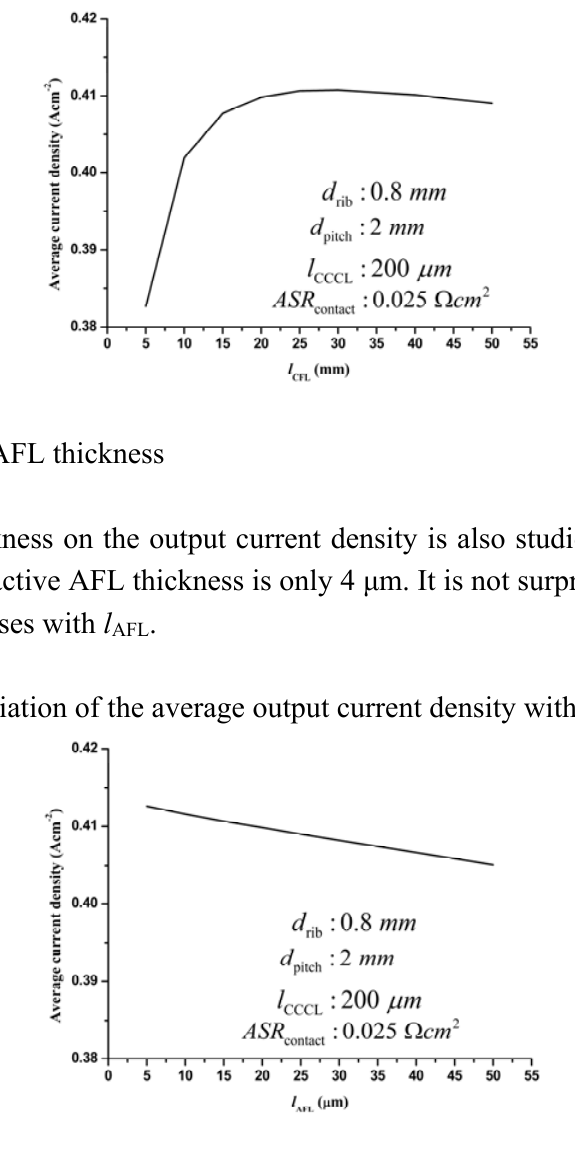
Figure 9. The variation of the average output current density with the CFL thickness.